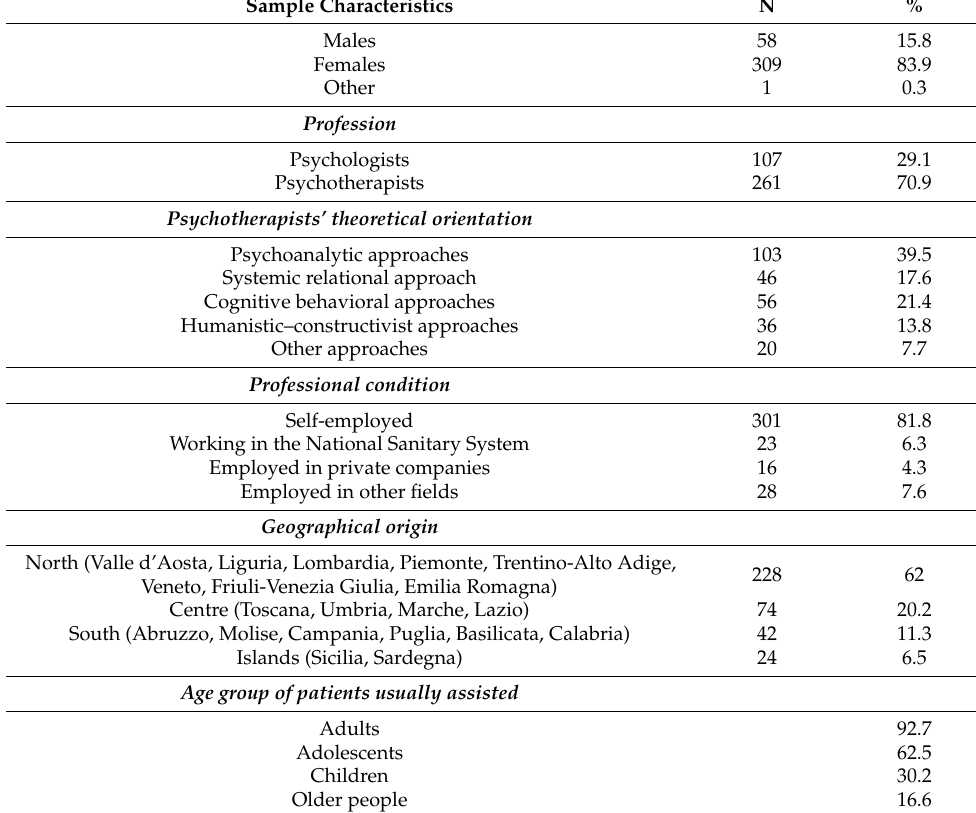
Table 1. Socio-demographic descriptive statistics of the